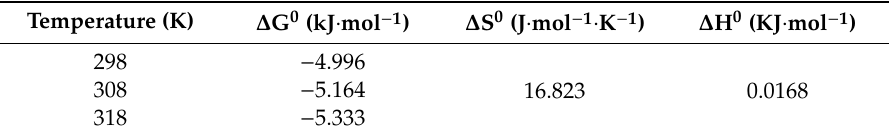
Figure 7. ( a ) Adsorption capacities of PANI/PSMA for MO at different temperature with initial dye concentration of 100 mg/L (pH = 4.0). ( b ) Plots of lnQe/Ce against 1/T for the adsorption of MO onto the PANI/PSMA. Table 3. Thermodynamic parameters for the adsorption of MO onto the PANI/PSMA at pH 4.0.